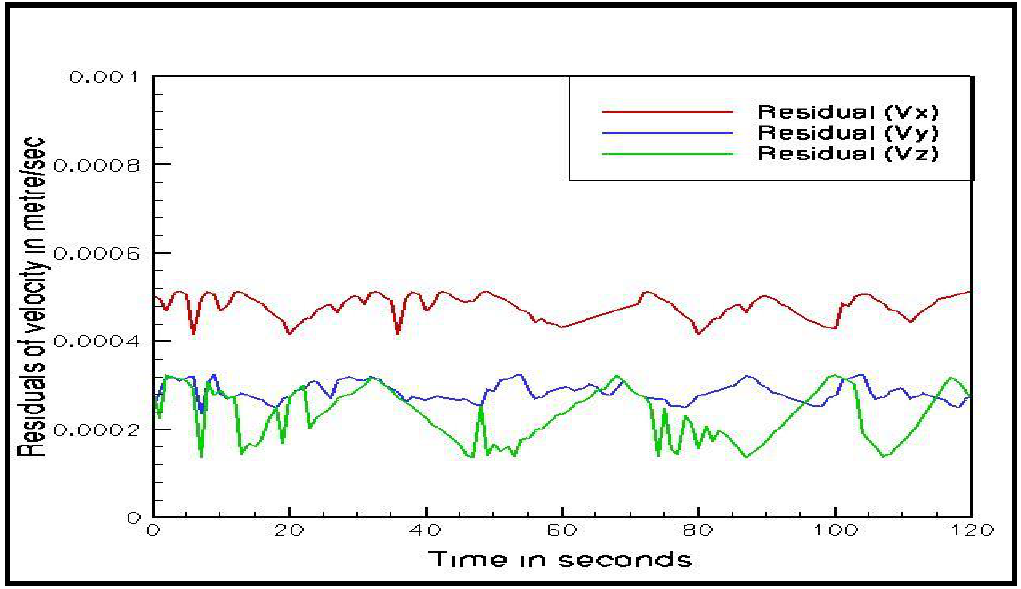
Fig. 5. Residual of 4 th order derived velocity from precise one for Day of Year (DOY:138), starting from